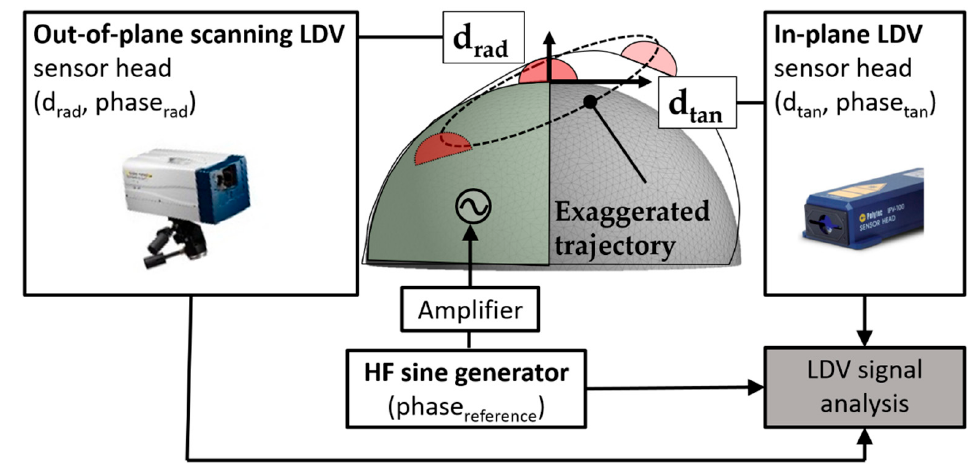
Figure 6. Laser Doppler vibrometer setup.